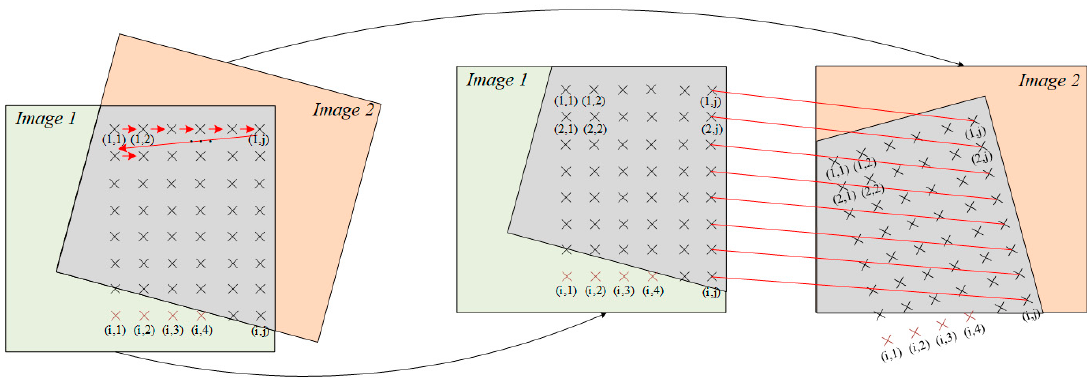
Figure 5. Registration point selection process.